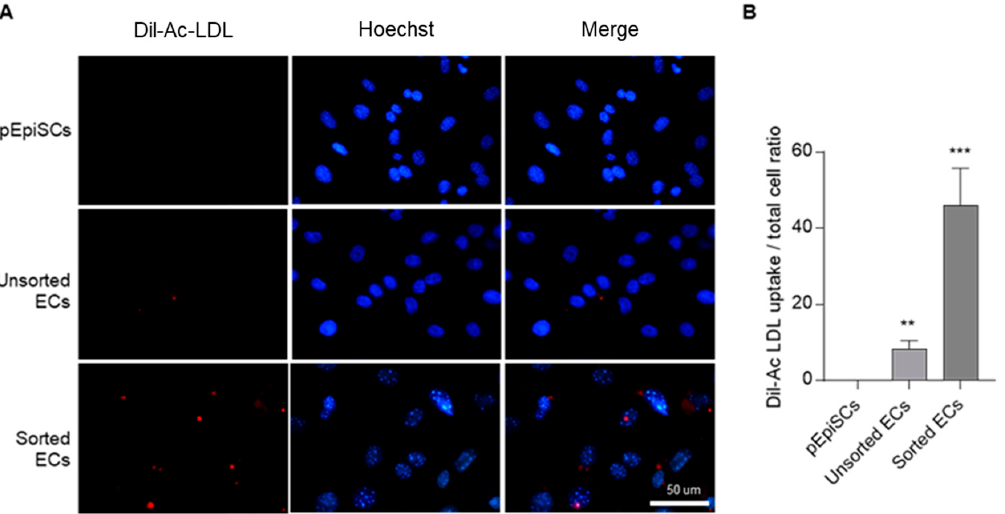
Figure 5. Uptake of Dil-acetylated low-density lipoprotein of Sorted ECs. ( A ) Dil-Ac-LDL uptakes of pEpiSCs, unsorted ECs and sorted ECs were examined at 4.5 h. Blue: staining of Hoechst. Red: staining of Dil-Ac-LDL. Scale bar = 50 µm. ( B ) Quantification of Dil-Ac LDL uptake assay in pEpiSCs, unsorted ECs and sorted EC. Values presented as mean SEM. ** p < 0.01, *** p < 0.001 versus pEpiSCs, n.s.: not significant.